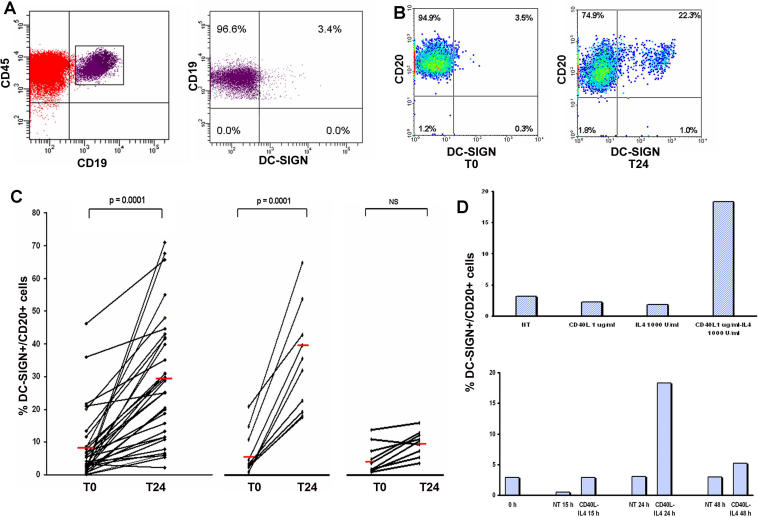
Expression of DC-SIGN on B Cells(A) B cells within the PBMC population expressed DC-SIGN. PBMC were assessed for expression of CD45, CD19, and DC-SIGN by flow cytometry. Cells coexpressing CD45 and CD19 (left) were analyzed for DC-SIGN coexpression (right). Quadrant positions were determined with the isotype controls.(B) Increase in coexpression of DC-SIGN on CD20+ cells detected by flow cytometry in unstimulated, purified, fresh B cells (0 h; T0) and IL-4– and CD40L-stimulated, purified B cells at 24 h (T24). Data are from a representative, healthy HIV-1–seronegative donor.(C) DC-SIGN expression on B cells from healthy, HIV-1–seronegative donors (n = 33, left), HIV-1–seropositive, ART therapy–naive subjects (n = 10, middle), and HIV-1–seropositive subjects receiving ART (n = 10, right). Quadrants were positioned on the isotype controls.(D) CD40L and IL-4 acted synergistically in inducing enhanced DC-SIGN expression in B cells by 24 h. In this representative experiment (top), purified B cells were cultured in the presence of IL-4 or CD40L or a combination of the two. Untreated B cells were used as controls (NT). DC-SIGN and CD20 coexpression on activated B cells was greatest using a combination of 1,000 U/ml of IL4 and 1 μg/ml of CD40L for 24 h (bottom). Single concentrations of 100, 500, and 2,000 U/ml of IL-4 and 0.1, 0.5, and 10 μg/ml of CD40L induced similar, low levels of DC-SIGN expression (unpublished data); various combinations of these concentrations of IL-4 and CD40L induced less DC-SIGN expression than this combination (unpublished data).